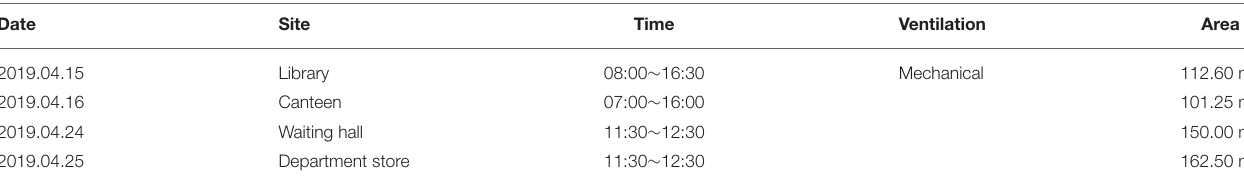
TABLE 1 | The timetable of the field